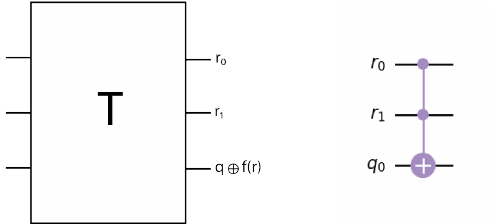
Figure 8. Schema of the T operator for testing if the target position in a 2 × 2 map has been reached. The controlled qubit’s phase is inverted when the robot reaches the position indicated by the target g = ( g 0 , g 1 ) = ( 1,1 ) or, equivalently, when the function f of (6) outputs